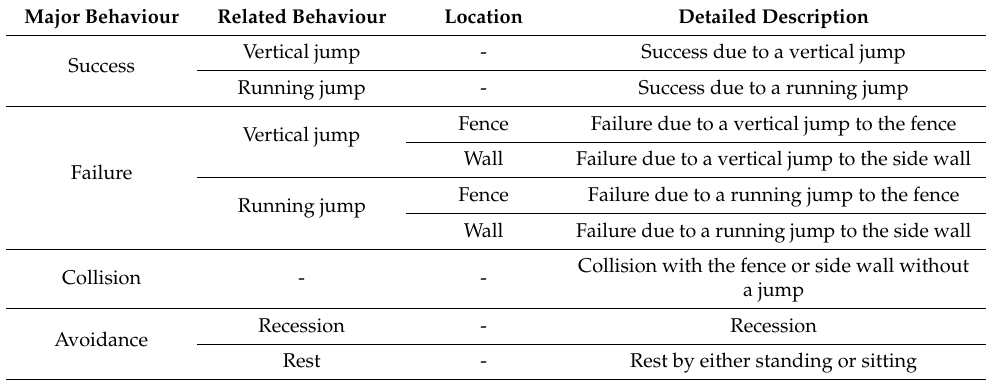
Table 1. Classification and description of response